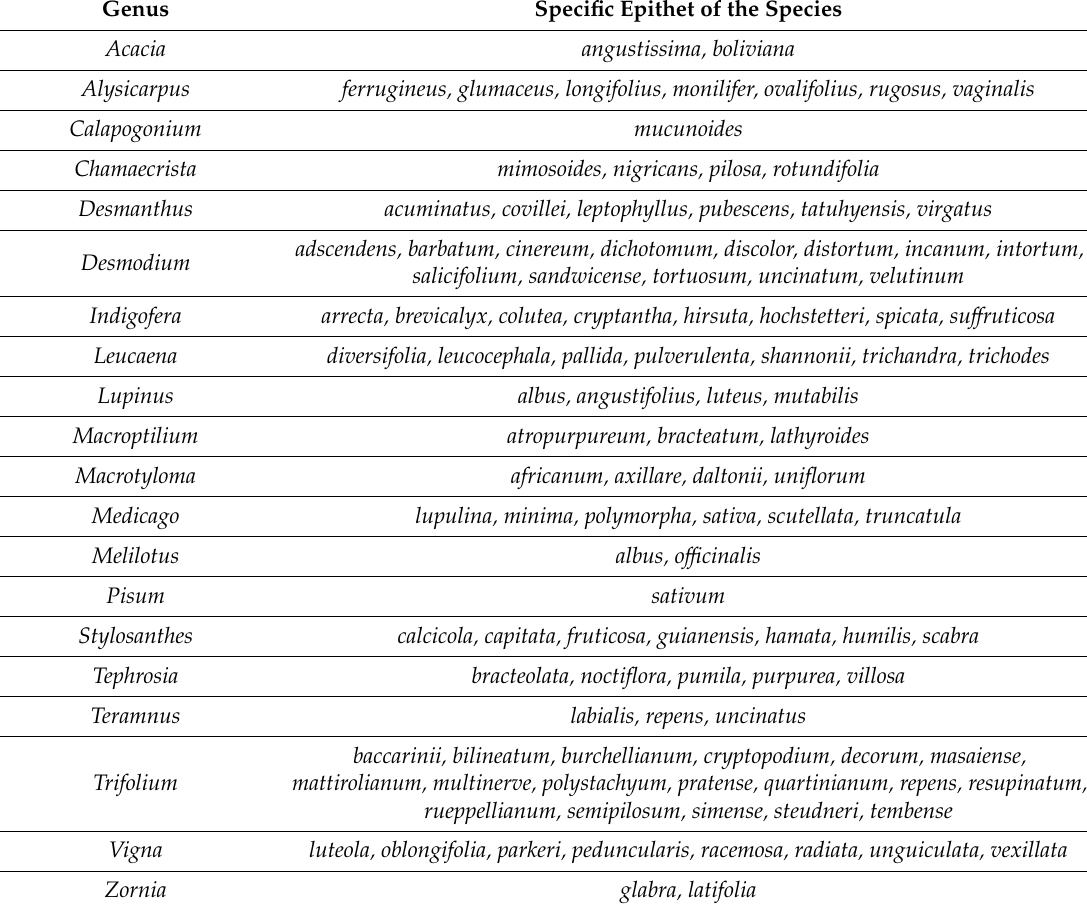
Table 4. List of forage legume species with long-lived seeds under medium-term storage (circa 8 ◦ C with 5% moisture content) at ILRI for which monitoring intervals of 15 years for high-quality seed accessions under such storage conditions are